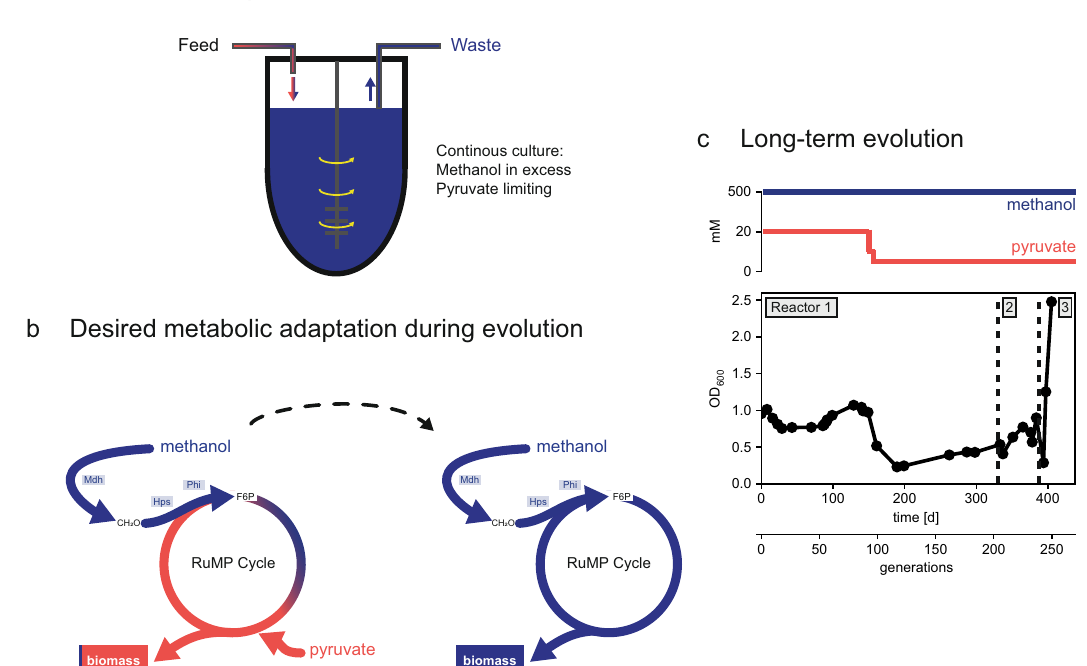
methanol and pyruvate in the feed medium and the dilution rate of the cultureare showninthetoppaneland observationsintermsofthedensityofthecultureover timeandnumberofgenerations.Duetotechnicalissues,thereactor1wasrestarted after 200 generations (reactor 2) and reactor 2 after 223 generations (reactor 3). Source data are provided as a Source Data fi le.